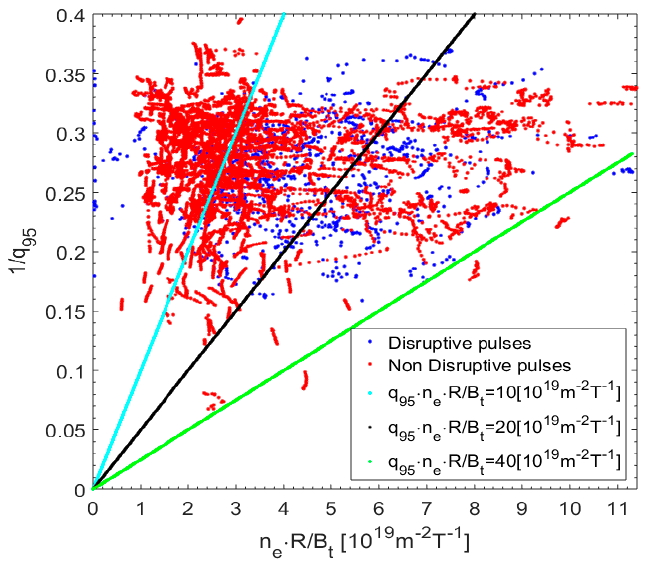
Figure 1. Hugill plot for a large database of JET with the ITER-like Wall (ILW) covering campaigns C29–C30. The disruptive and safe discharges overlap completely in this space. For the non-disruptive discharges, 14 samples during the flat top are shown. For the disruptive discharges, 14 samples, taken during the 210 ms before the beginning of the current quench, are reported.